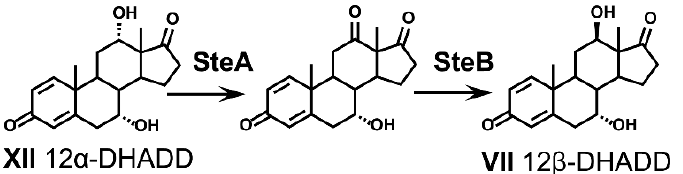
Figure 7. Stereoconversion of the 12-hydroxy group during bile acid degradation. Enzymes were identified in C. testosteroni TA441. For bile acids, the respective deprotonated bile salts are de- picted.